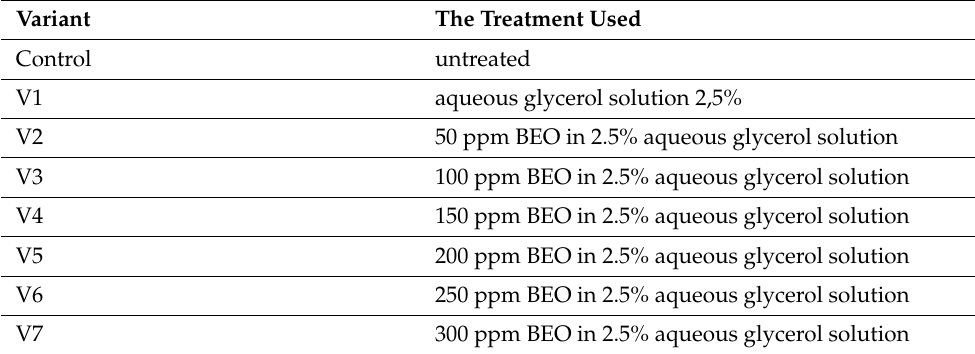
Table 1. Basil oil concentrations used in tomato